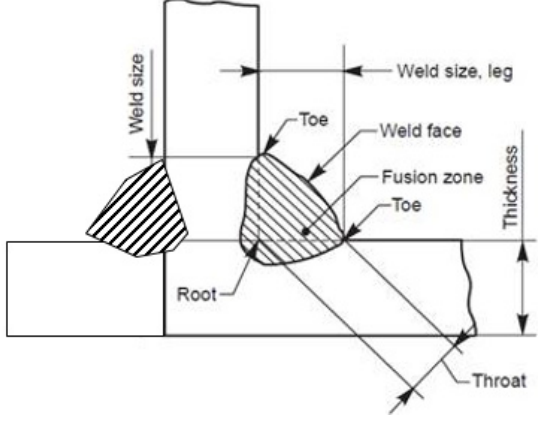
Figure 2. Weld detail of a T-joint with fillet weld. Figure 1. Weld detail of a T-joint with fillet weld.